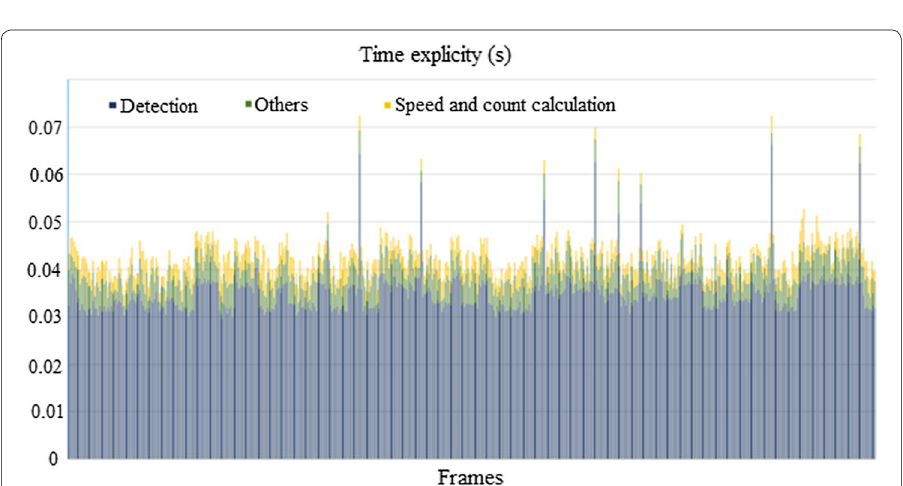
Fig. 20 The time of complete processing of one